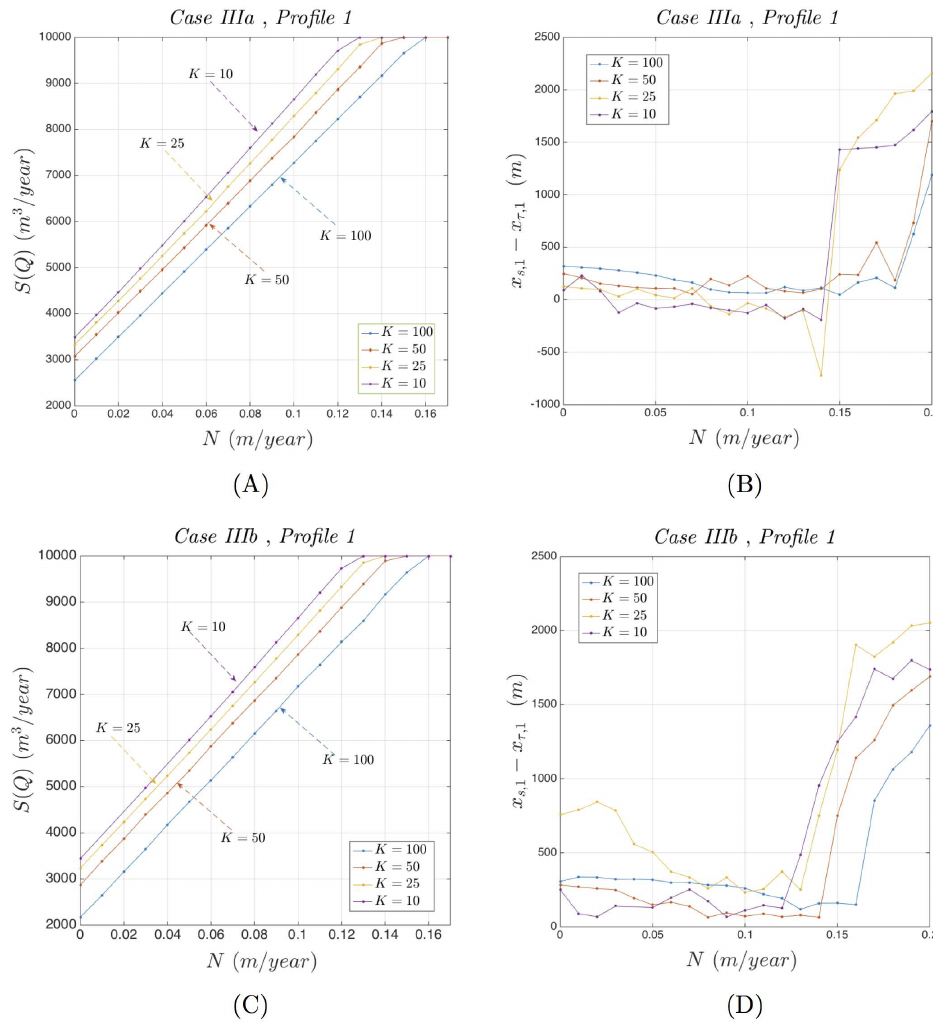
Fig 11. Behavior of S ( Q ) and Δ x s τ under Profile 1. Dependence of S ( Q ) and Δ x s τ on N and K for Test Cases IIIa and IIIb using Profile